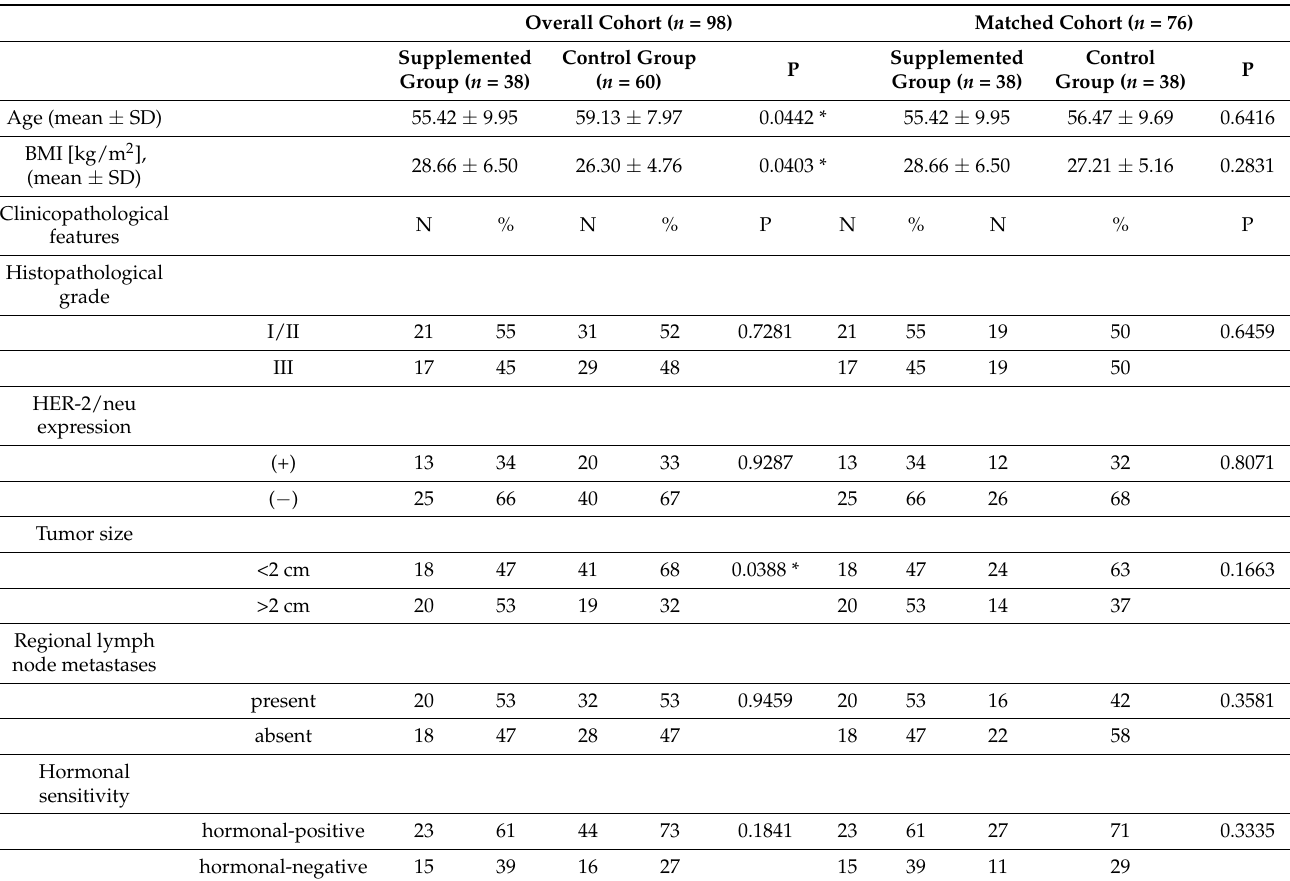
Table 1. The baseline characteristics of the overall and matched cohort of